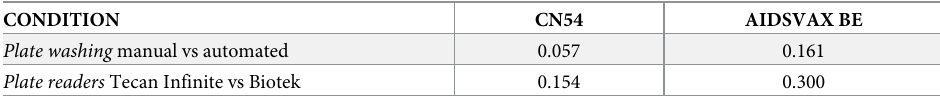
Table 3. Statistical comparison of robustness phase 1 parameters using paired student’s